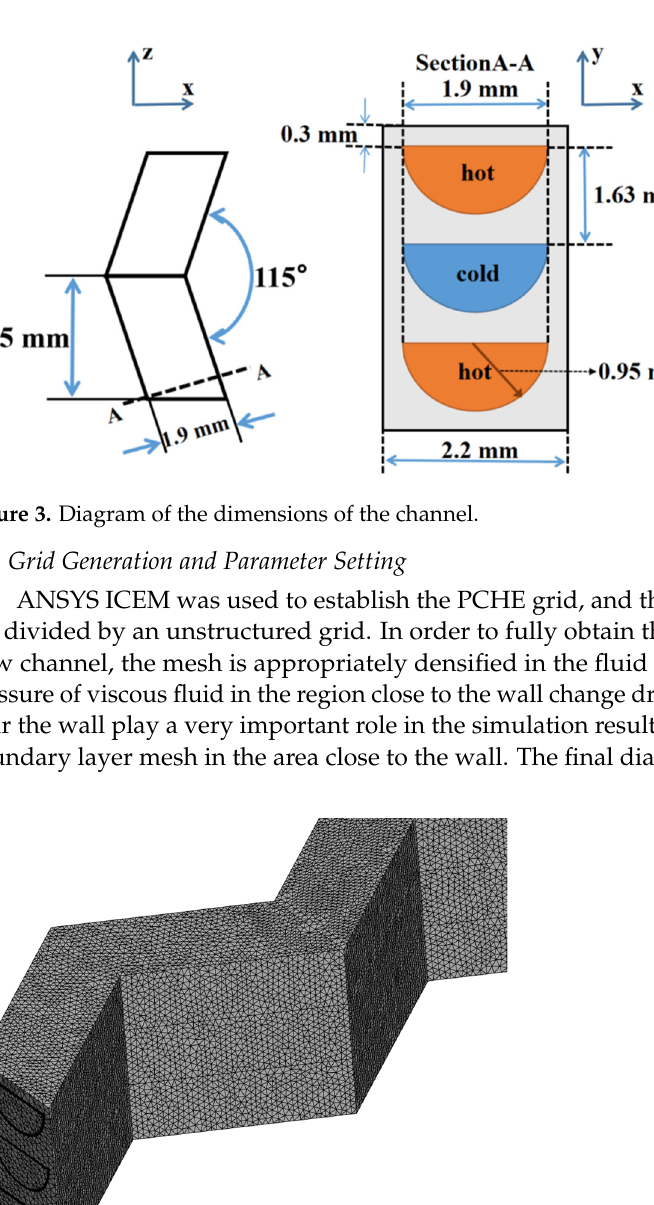
Figure 2. Diagram of PCHE channel section.